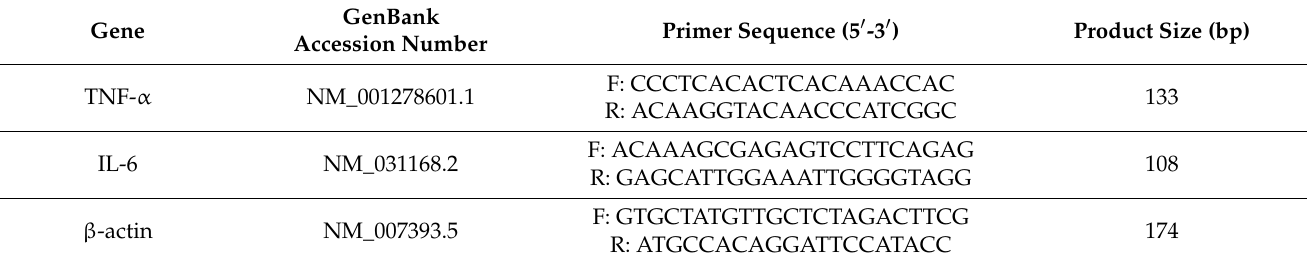
Table 2. Primers used for qRT-PCR.